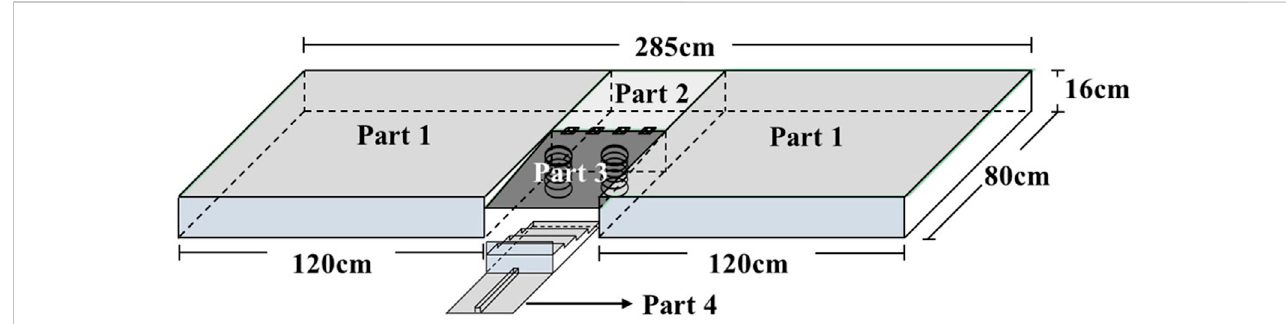
The design of the Ankle Inversion Discrimination Apparatus during walking (AIDAW) (Part 1: walking platforms; Part 2: bridging platform; Part 3: testing platform; Part 4: physical